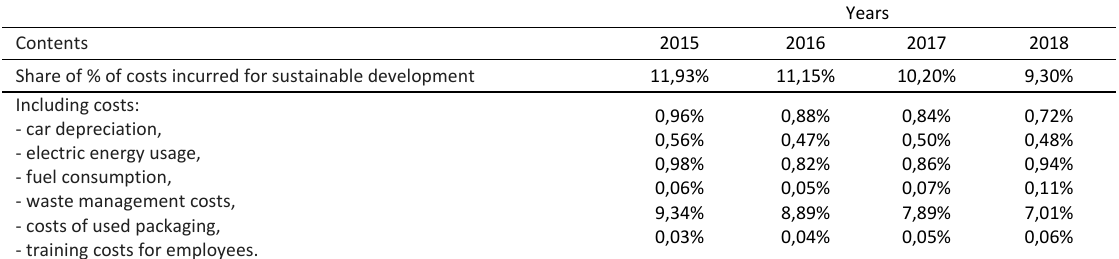
Table 2: The percentage share of selected cost items in the total costs of the enterprise